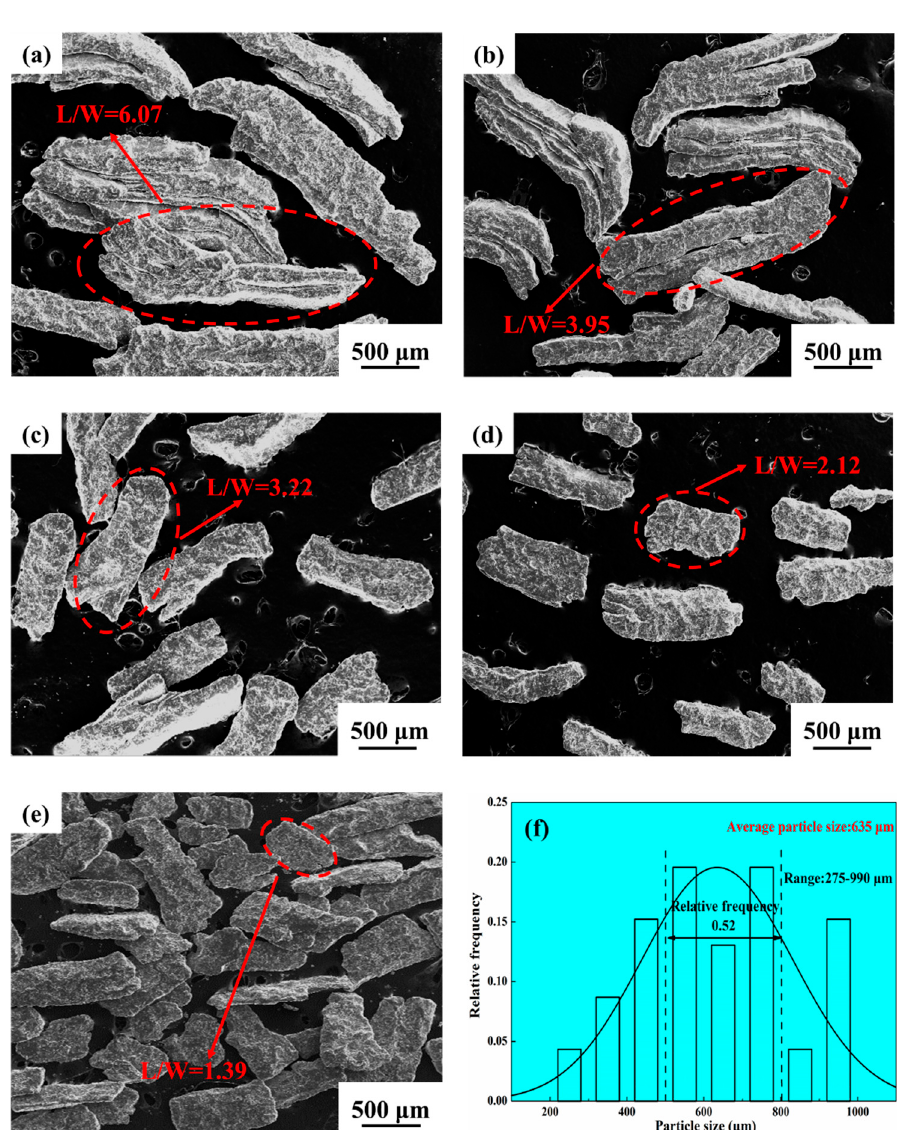
Figure 3. The evolution of powder morphology for AZ31 ‐ 5 wt % V P at different milling time: ( a ) 10 h, ( b ) 30 h, ( c ) 50 h, ( d ) 70 h, ( e ) 90 h, and the ( f ) distribution map of particle size for the samples milled for 90 h.